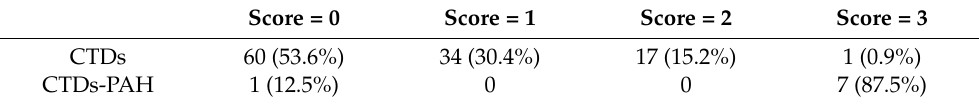
Table 3. Application of the CPET scoring system among CTDs patients.